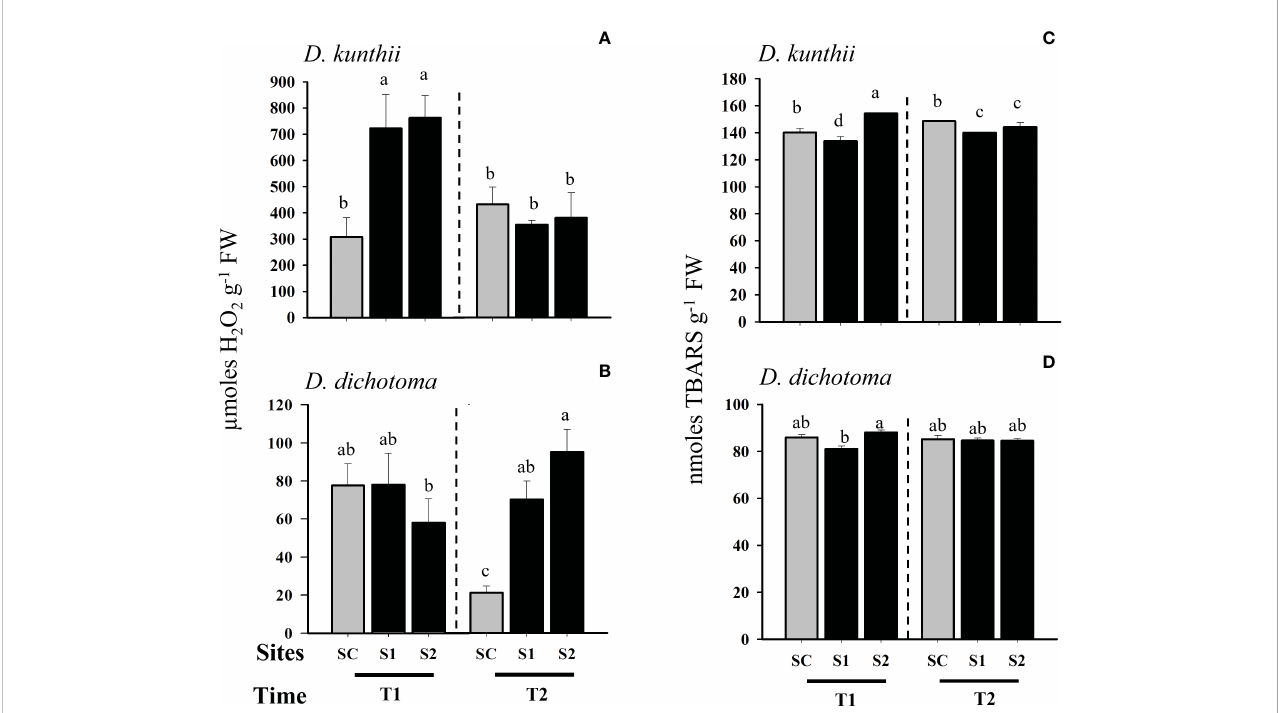
FIGURE 5 Oxidative stress quanti fi ed as H 2 O 2 and TBARS in D. kunthii and D. dichotoma transplants from brine discharge from a desalination plant. In D. kunthii , H 2 O 2 (A) and TBARS (C) were measured in 2 impacted sites with low (S1) and high (S2) in fl uence from brine discharge of a desalination plant located in Antofagasta, Chile, and using a control site (SC) at 3 (T1) and 7 (T2) days. In D. dichotoma , H 2 O 2 (B) and TBARS (D) were measured in 2 impacted sites with low (S1) and high (S2) in fl uence from brine discharge from a desalination plant located in Alicante, Spain, using a control site (SC) at 3 (T1) and 6 (T2) days. Data corresponds to mean ± SD ( n = 3). Letters represent statistical difference at 95% con fi dence interval (SNK test, p < 0.05).